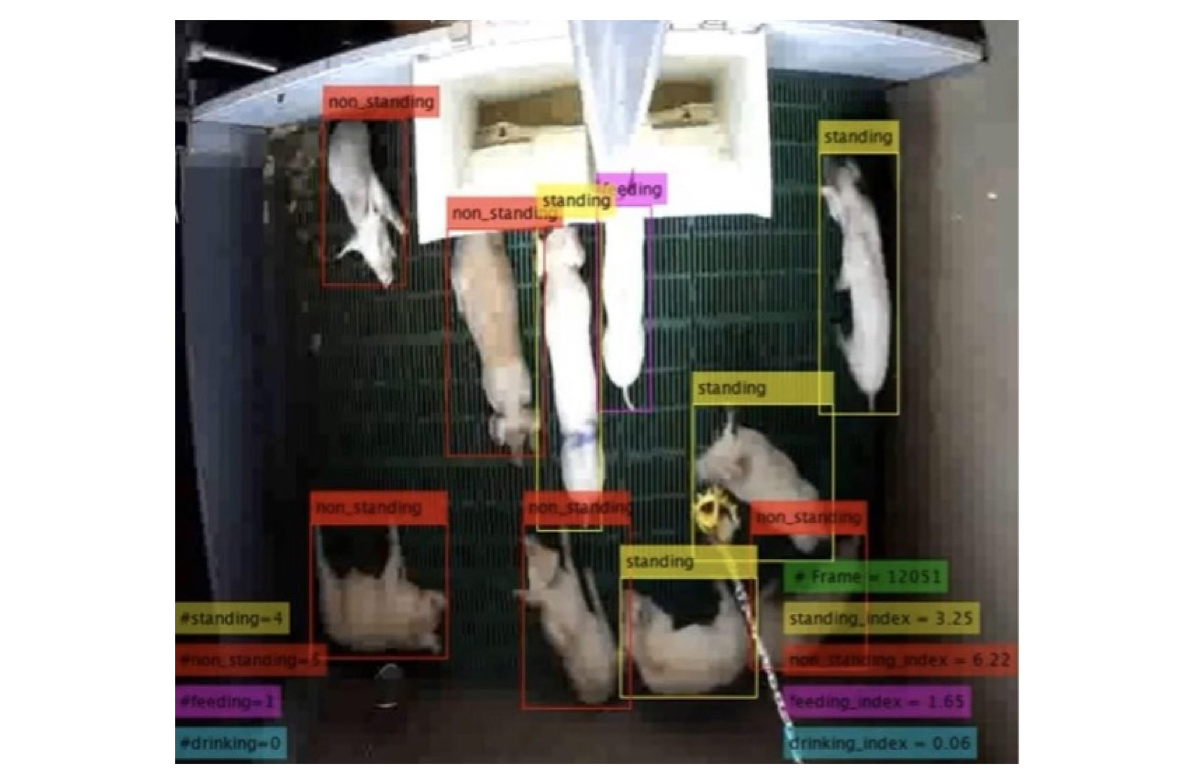
FIGURE2 Detection sample for an arbitrary pen of the experimental trial. The method quantifies the behavior of each pig at each time frame. The behavior index is then computed corresponding to the time frame, see Equation (2).